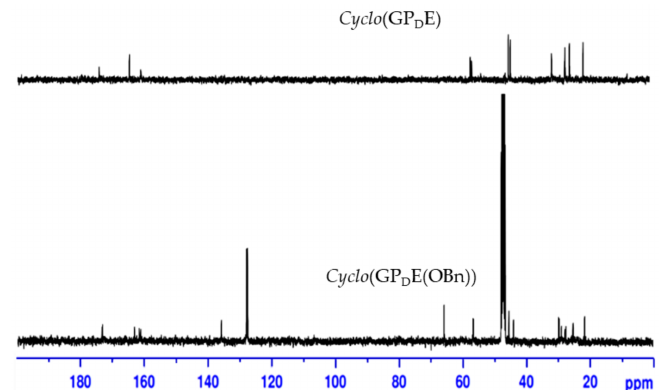
Figure 2. 13 C-NMR spectra of cyclo (GPDE(OBn)) and cyclo (GP D E) in D 2